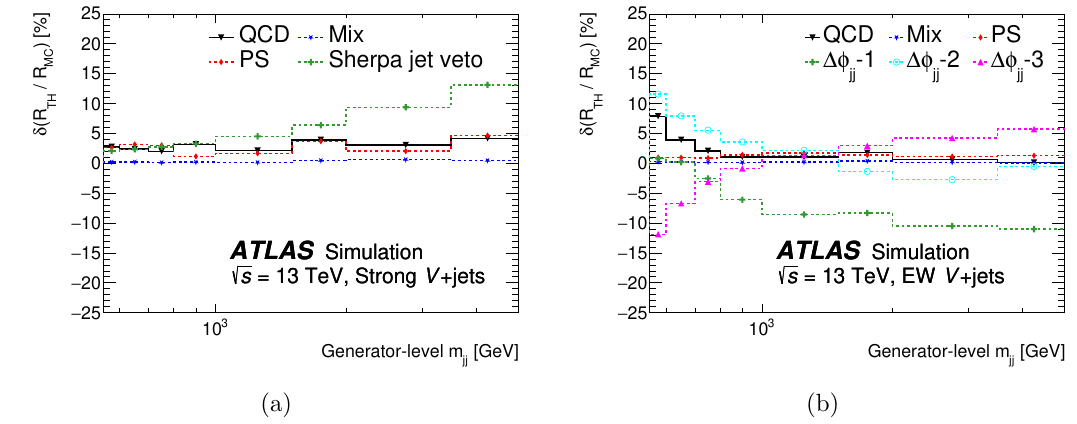
(cid:14) . ‘QCD’ refers to the change R Z/W TH MC -[1,2,3]’ uncertainty components quantify jj